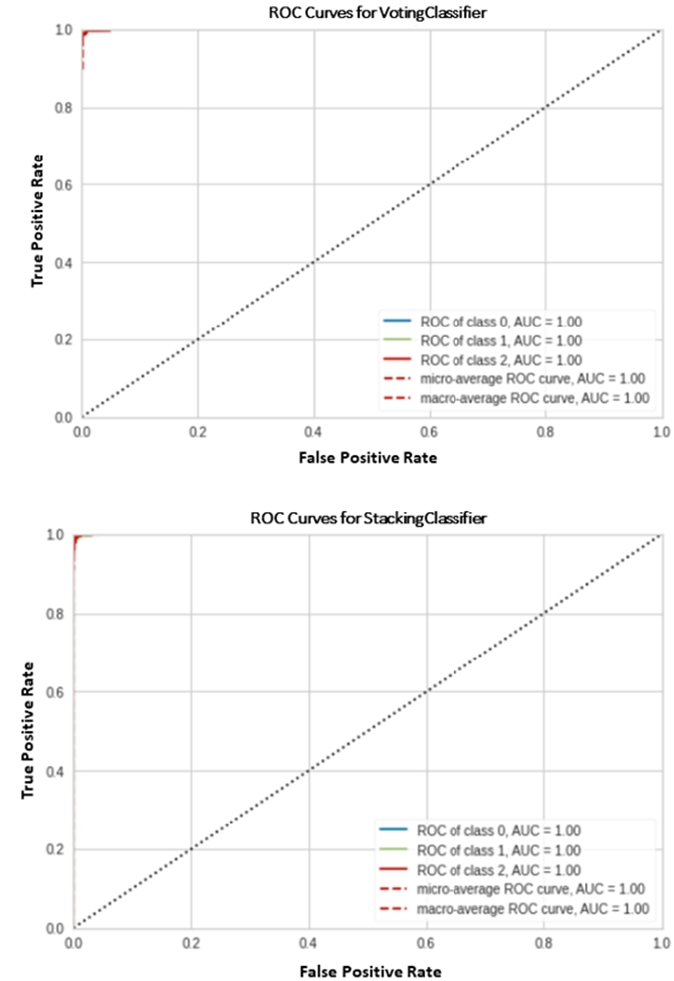
Figure 5. ROC curves for voting and stacking